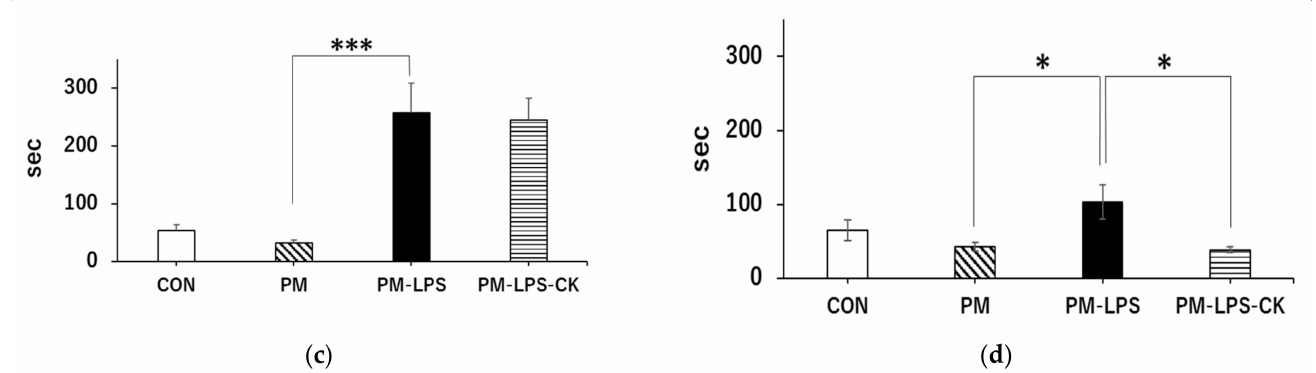
Figure 4. Effects of dried C. kawachiensis peel powder in the behavioral test. Measurement of total distance traveled in the ( a ) 2-day or ( b ) 8-day group in the Y-maze device. Measurement of immobility time in the ( c ) 2-day or ( d ) 8-day group using the ANY-maze Video Tracking System. Values are means ± SEM. Symbols show significant differences for the following conditions: PM vs. PM–LPS (* p < 0.05, *** p < 0.001), and PM–LPS vs. PM–LPS–CK (* p < 0.05). The number of mice in each group is as follows: ( a , c ) CON: n = 8, PM: n = 8, PM–LPS: n = 7, PM–LPS–CK: n = 8, and ( b , d ) CON: n = 8, PM: n = 8, PM–LPS: n = 7, PM–LPS–CK: n = 7.